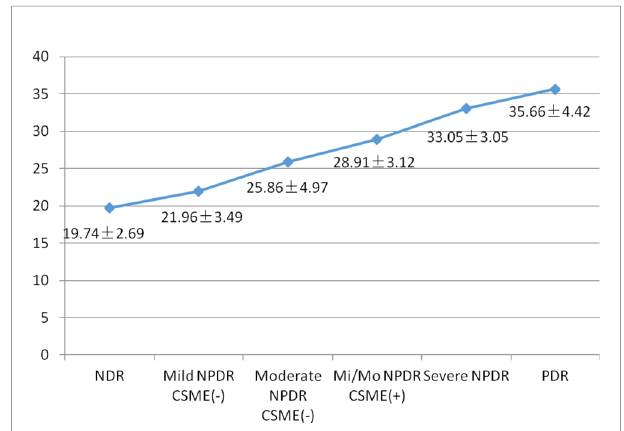
FIGURE 2 | Mean DR score in various stages of DR. NDR, no diabetic retinopathy; NPDR, non-proliferative diabetic retinopthy; Mi/Mo NPDR, mild or moderate non-proliferative diabetic retinopthy; PDR, proliferative diabetic retinopthy.